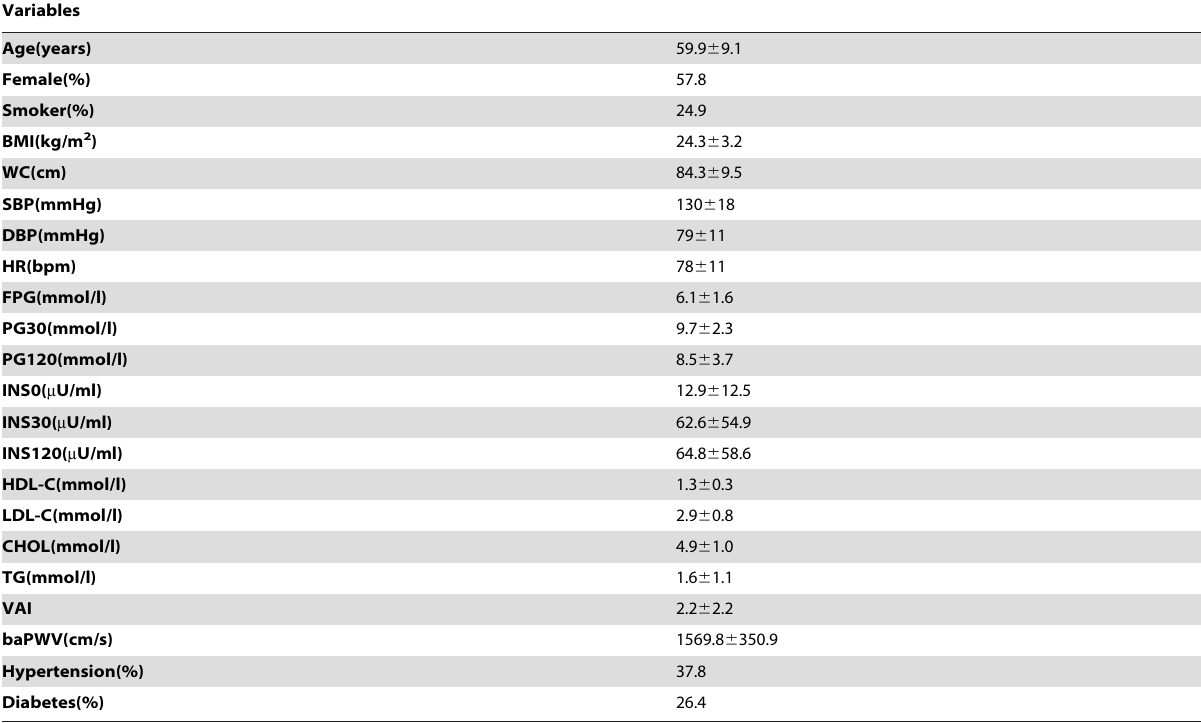
Table 1. Clinical and laboratory